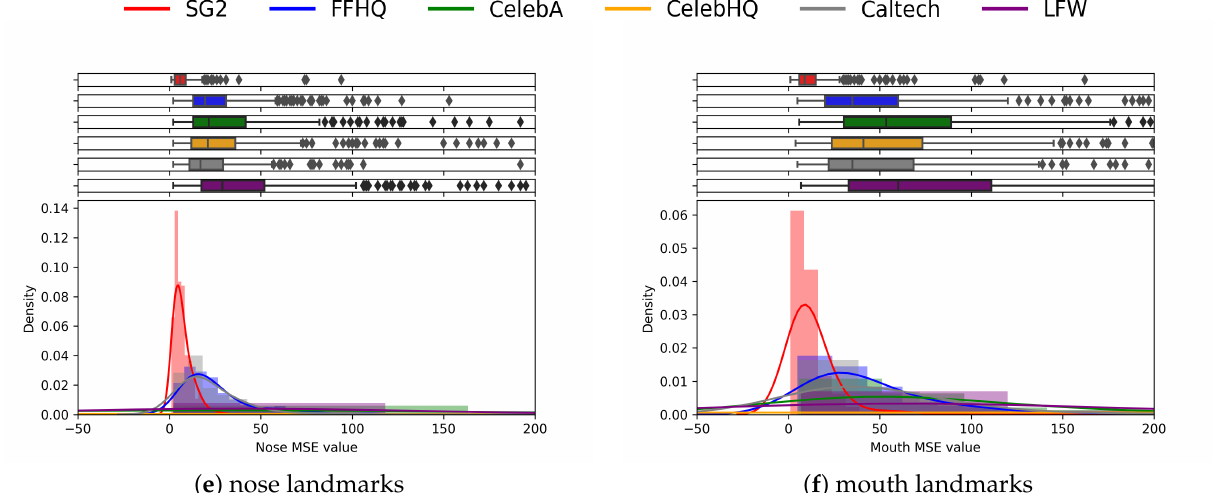
Figure 9. Plots above visualize the histograms of the distributions of the landmarks of different areas of the face for the different datasets. The full set of landmarks shows better discrimination capability.